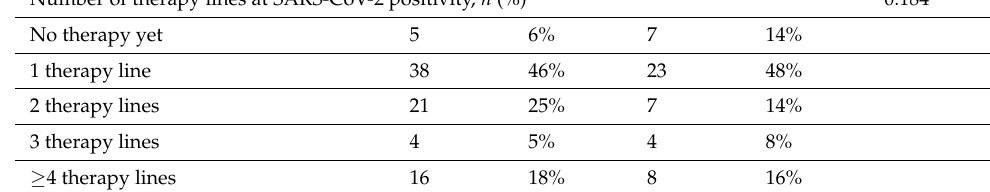
Number of therapy lines at SARS-CoV-2 positivity, n (%)